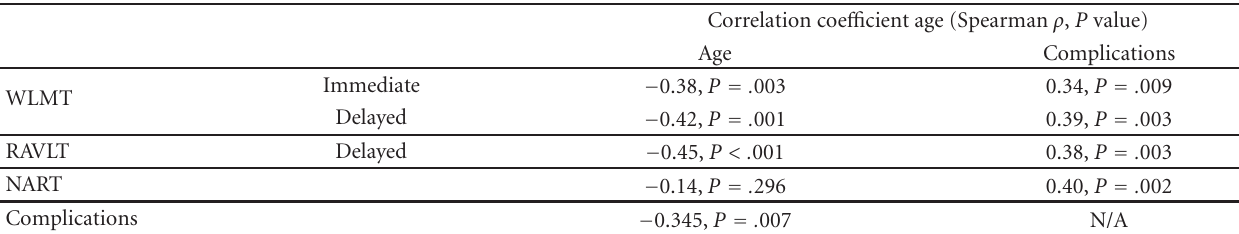
Table 3: Correlation of cognitive testing with age and complication